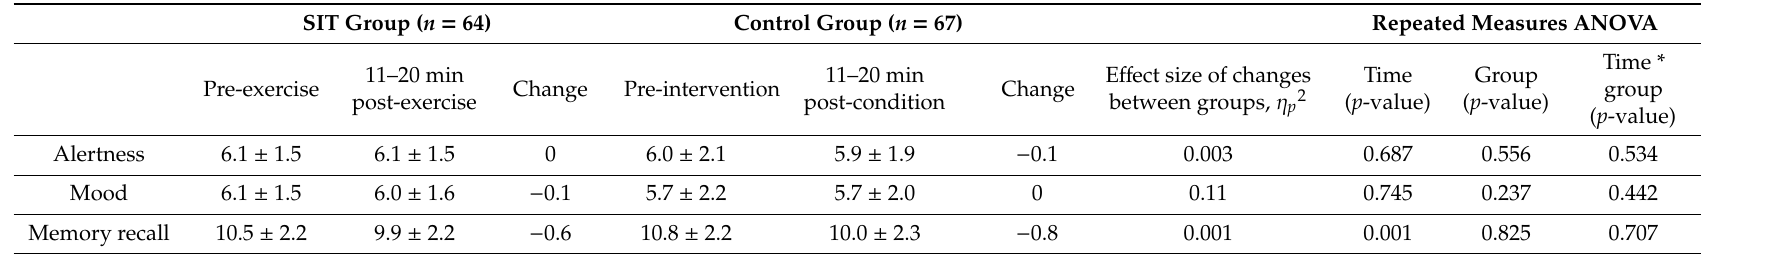
Table 2. Mean ± SD of alertness, mood, and memory recall of female secondary school